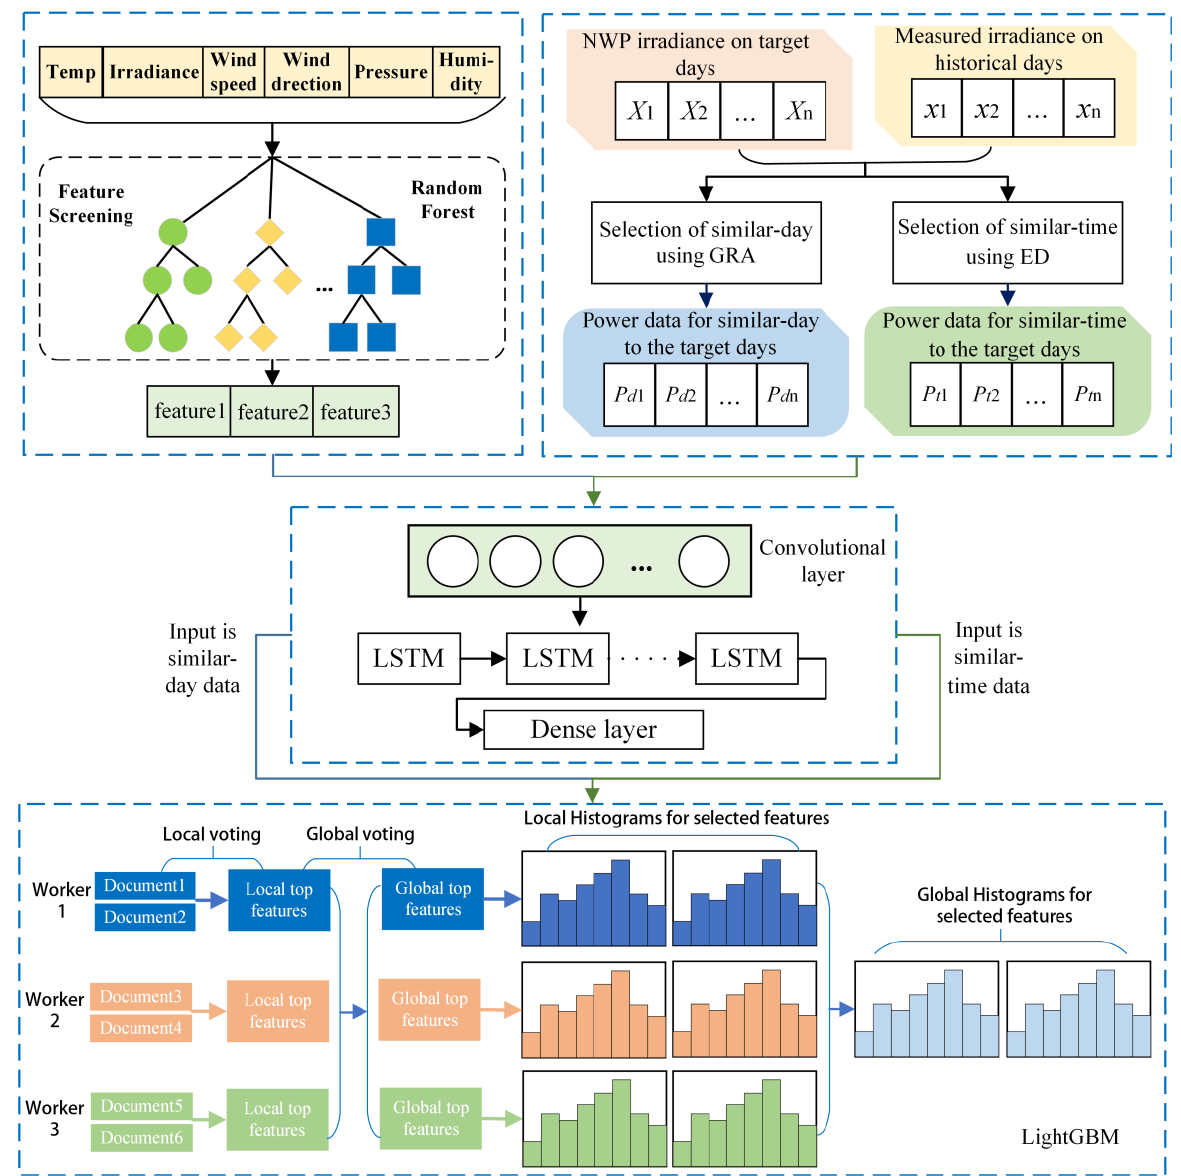
Figure 4. Flowchart of forecasting structure.